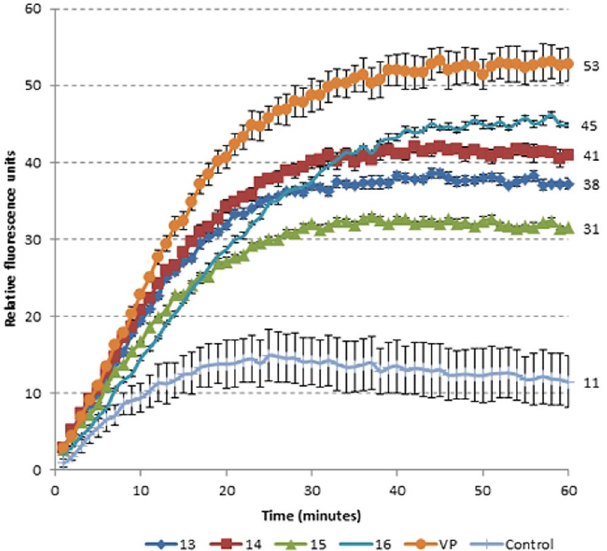
Figure 2. Efflux pump inhibition (EPI) of M . aurum under the pressure of methyl disulfides 13 – 16 . Ethidium bromide (EtBr), an efflux pump substrate was used at a final concentration of 1.3 µ M (0.5 mg L − 1 ). Its accumulation within the bacterial cells is an indicator of disruption of the efflux mechanism and was detected using fluorescence emissions. Verapamil (VP), a known efflux pump inhibitor, and a drug-free culture were used as positive and negative controls respectively. Low (11–20 rfu) to very high ( > 50 rfu) inhibition of efflux are represented by the numbers at the side of the graph. The experiments were performed in triplicate ( n = 3) and the graph was plotted using the averages. (rfu = relative fluorescence